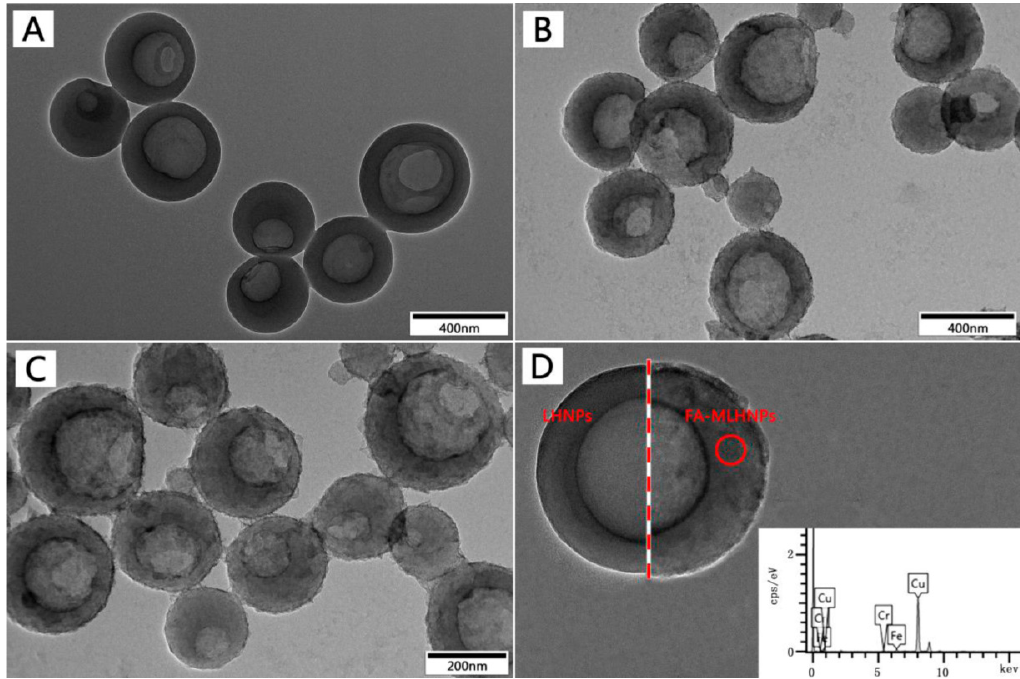
Figure 2. Transmission electron microscope (TEM) images of ( A ) LHNPs, ( B ) MLHNPs, ( C ) FA-MLHNPs. ( D ) Schematic comparison of the two types of LHNPs in this study, the inset is the energy spectrum of the surface of FA-MLHNPs.